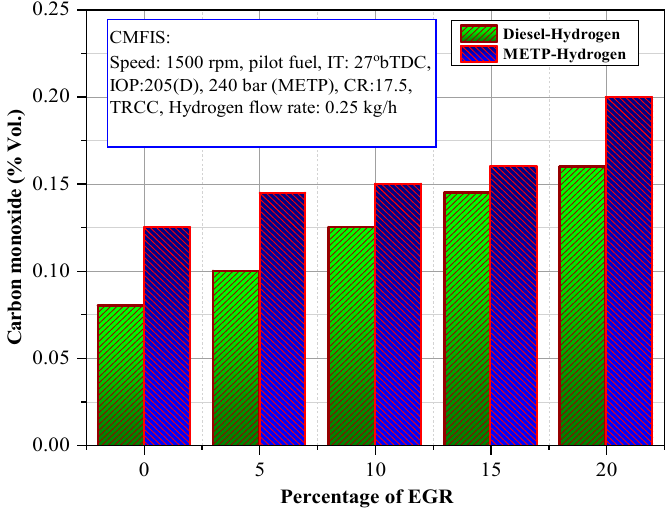
Figure 7. Influence of EGR on the HC with the induction method.